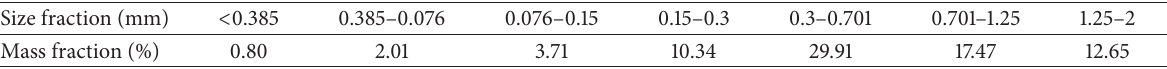
Table 1: Size fraction distribution.